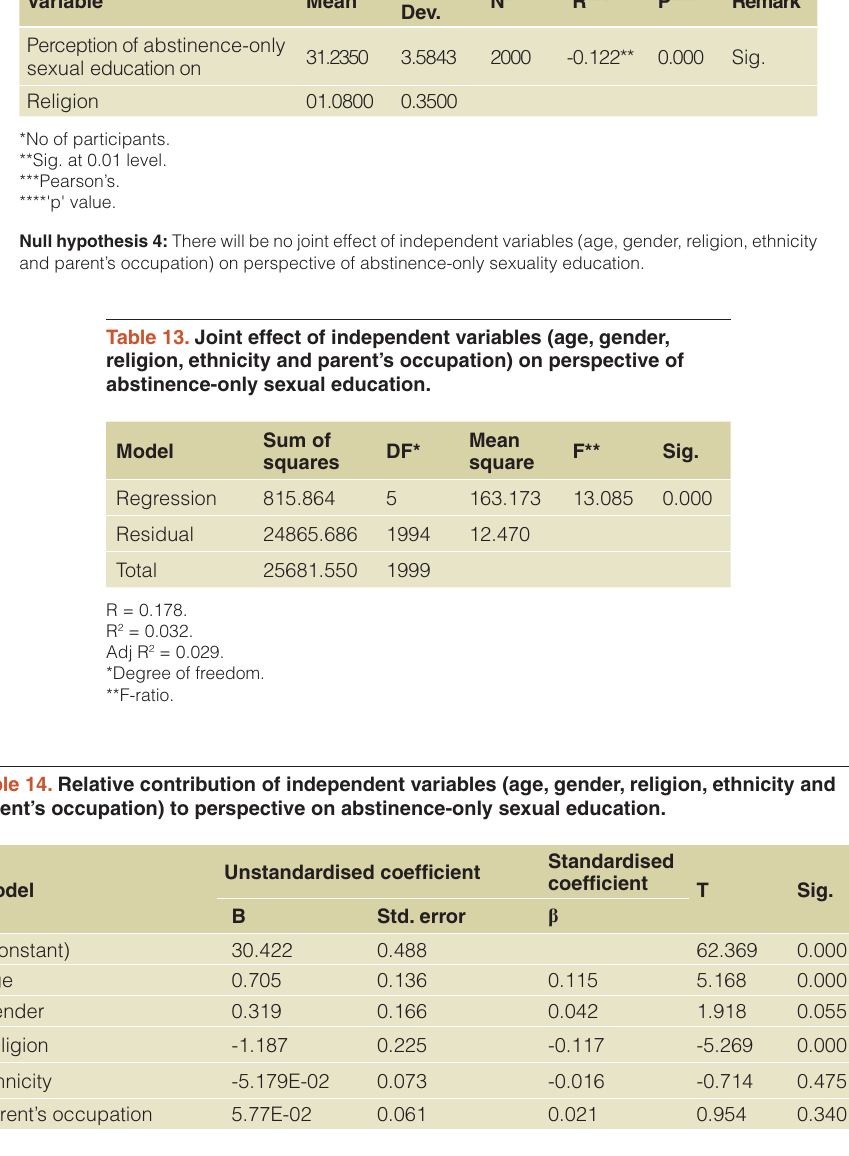
Table 12. Relationship between religion and perspective on abstinence-only sexual education.